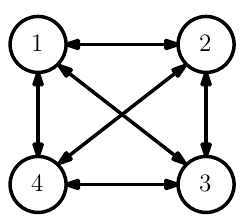
Figure 3. A network constituted by 4